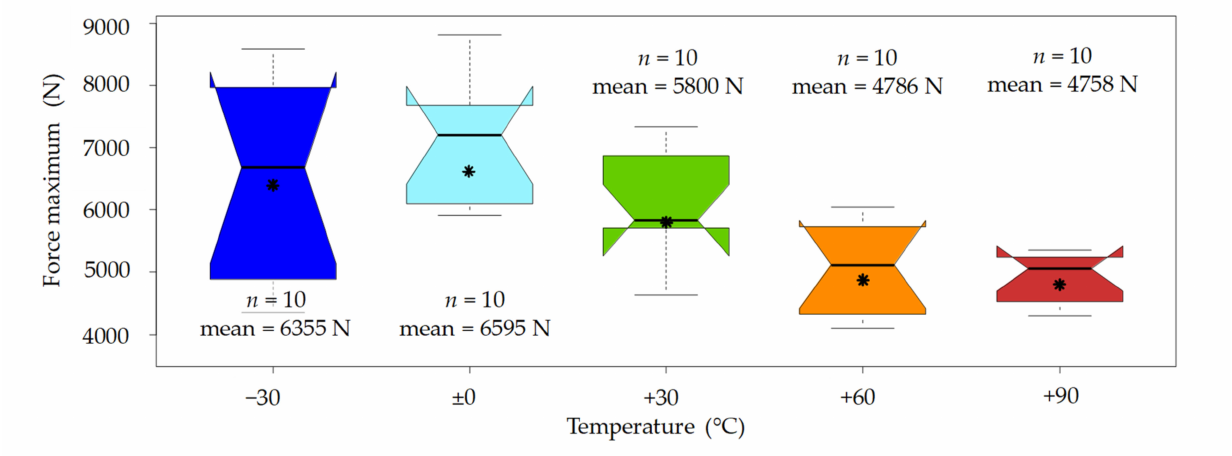
Figure 9. Boxplots of the obtained force maximums from the beech wood tests by temperature level. * An interpretation aid concerning the boxplots can be found in Appendix A, Figure A1.